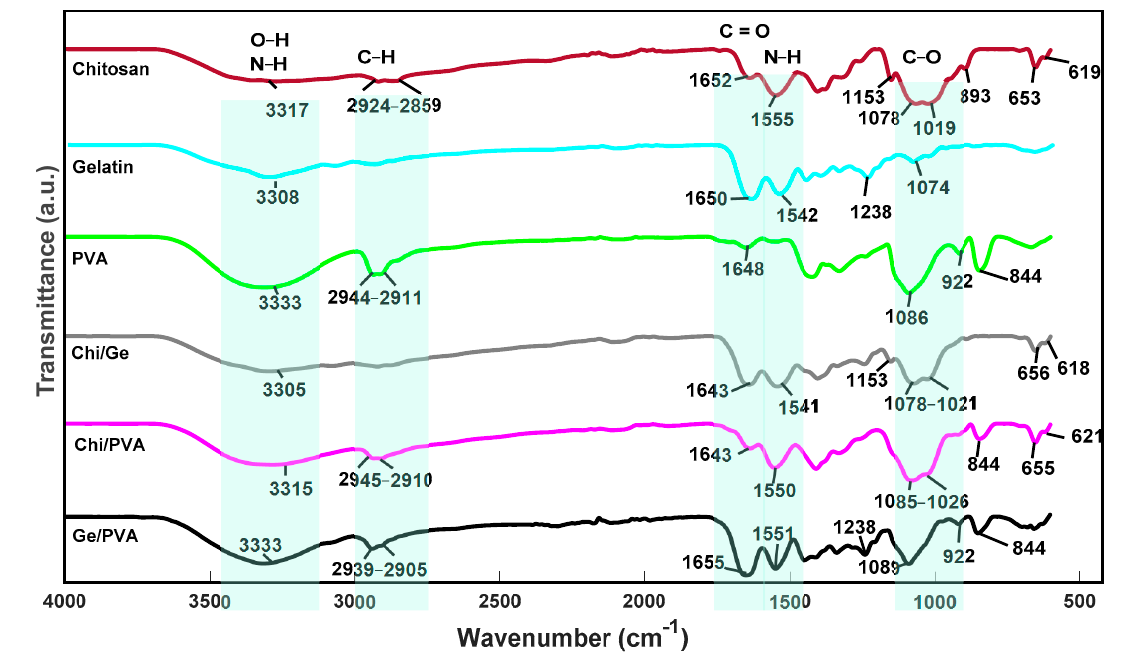
Figure 6. FTIR spectra of scaffolds control.